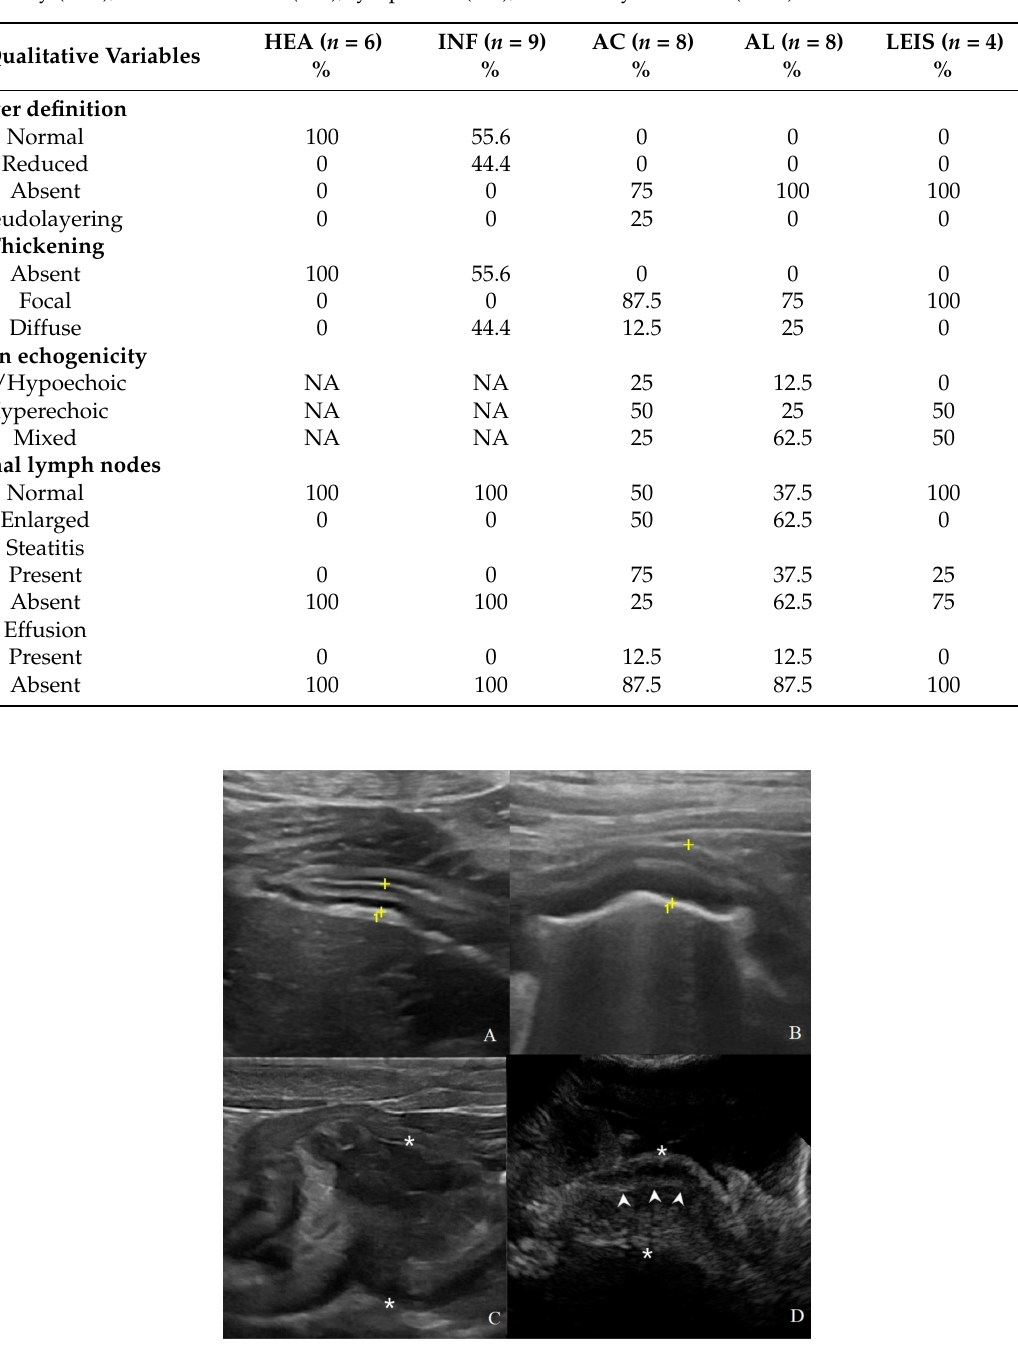
Table 2. Number of cases ( n ) and percentage (%) showing qualitative features at B-mode ultrasound for healthy (HEA), inflammatory (INF), adenocarcinoma (AC), lymphoma (AL), and leiomyosarcoma (LEIS).